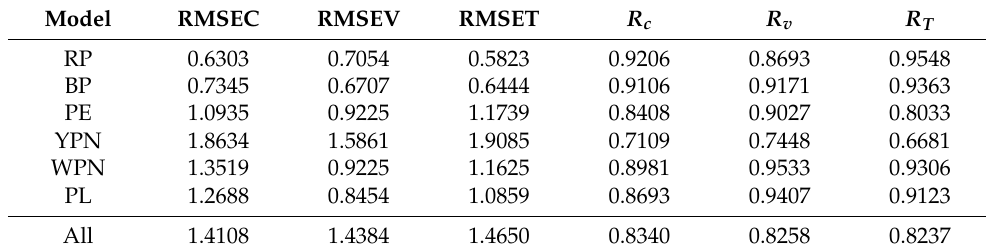
Table 4. Soluble solids models